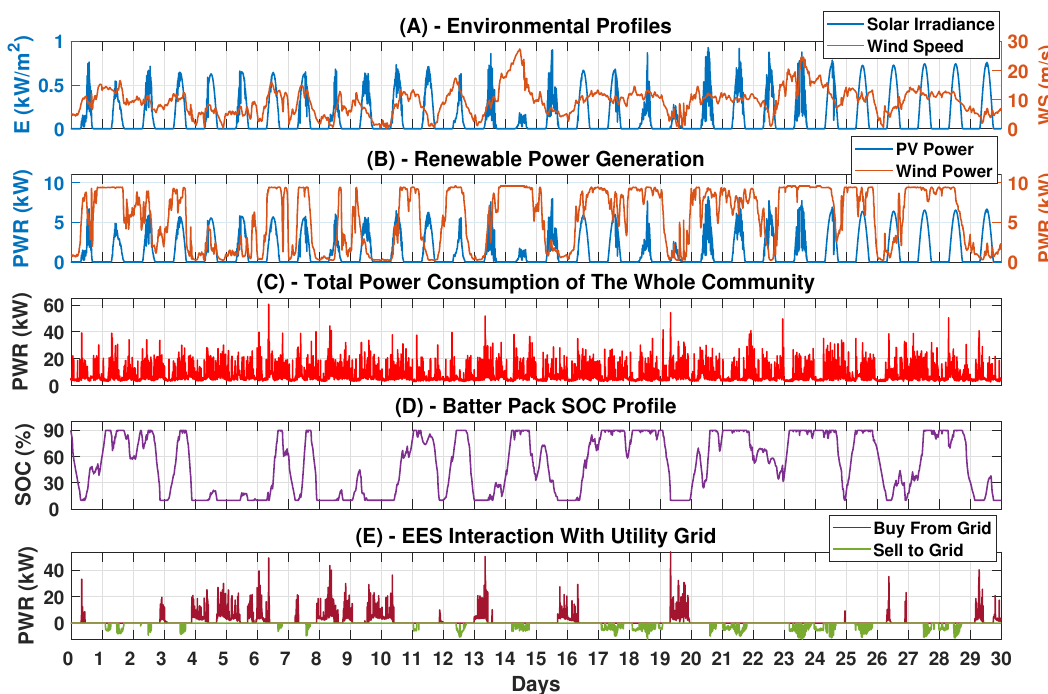
Figure 6. One-month long simulation of the EES in terms of power tracing quantities. The solar irradiance and wind profiles shown in ( A ) illustrate different daily weather conditions; the corresponding power generation by PV array and wind turbine indicated by ( B ); ( C ) reports the load power consumption of the whole residential community; battery SOC profile is shown in ( D ), within its operating range from 10% to 90%; the interactions with utility grid to buy or sell energy due to the energy surplus and deficit are illustrated in ( E